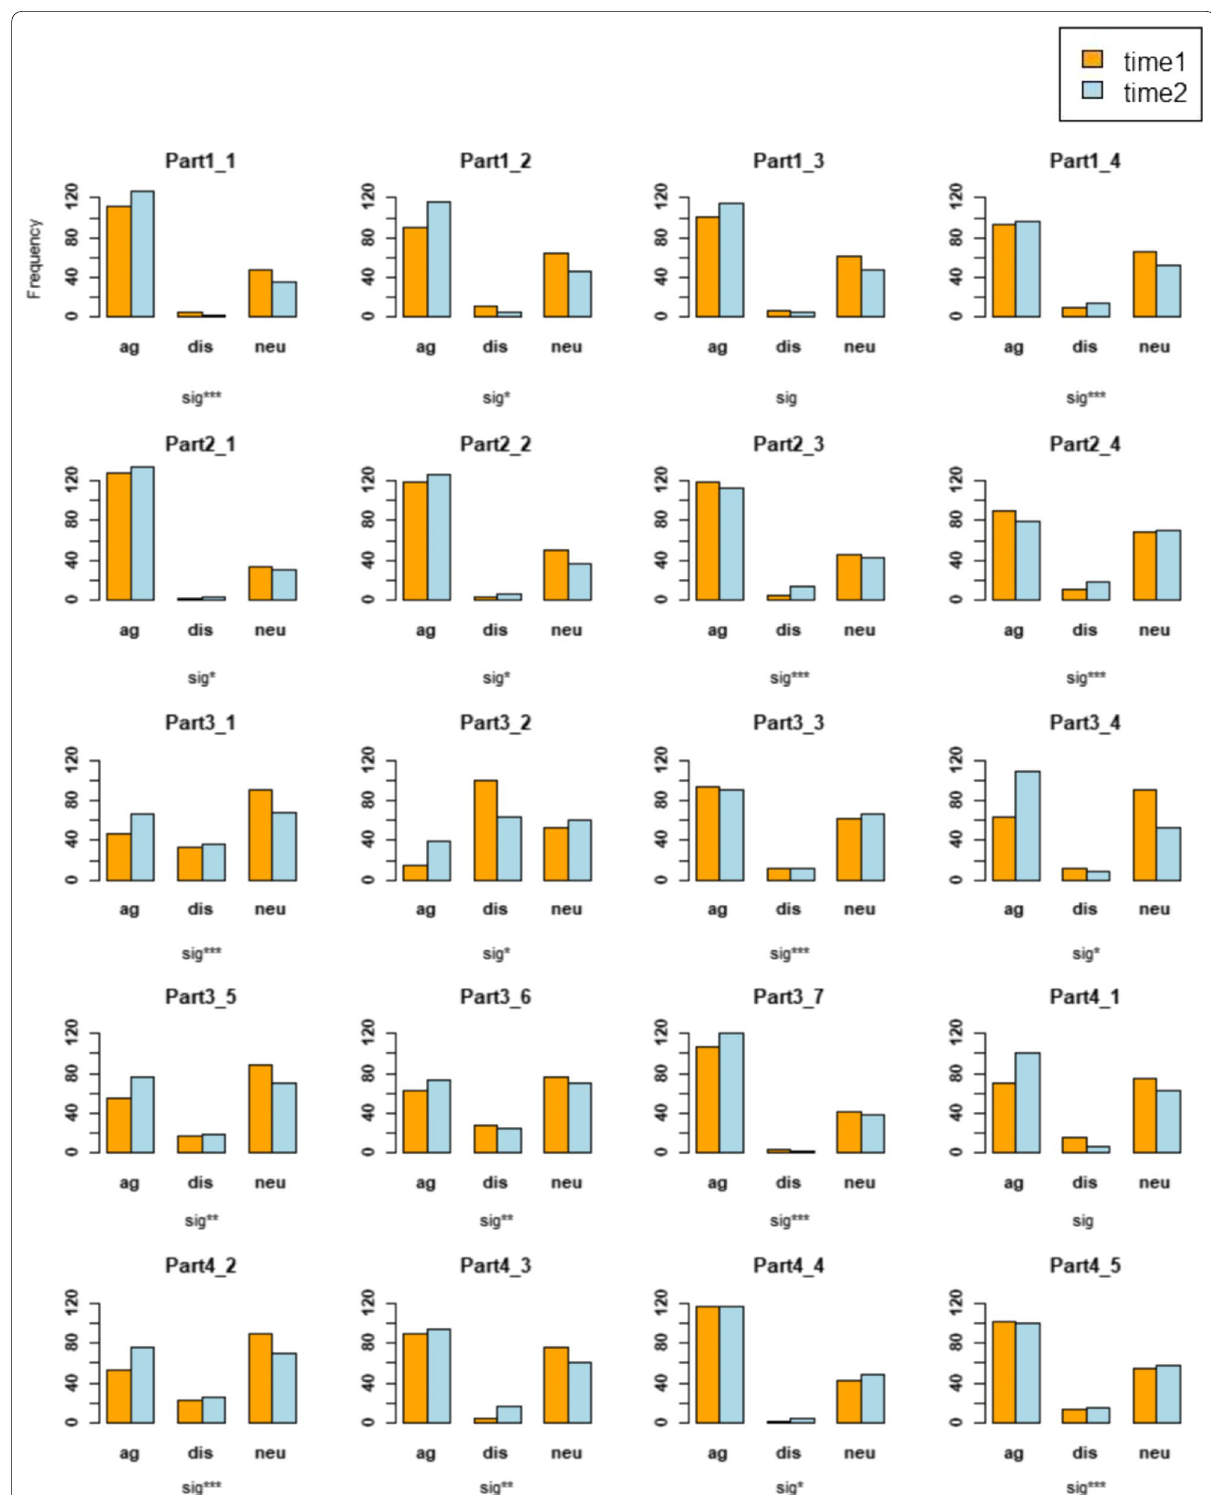
Fig. 3 Students’ evaluation of the crowdsourcing-based teaching model before and after the course, based on NPT scale dimension-specifically. Notes ： NPT, Normalization Process Theory, which has four dimensions (i.e. coherence, cognitive participation, collective action and reflexive monitoring) noted as Part 1 to Part 4 in the figure. Each dimension contains several questions, noted by the item number. ag: agree, dis: disagree, neu: neutrality. sig*: P < 0.05, sig**: P < 0.01, sig***: P <